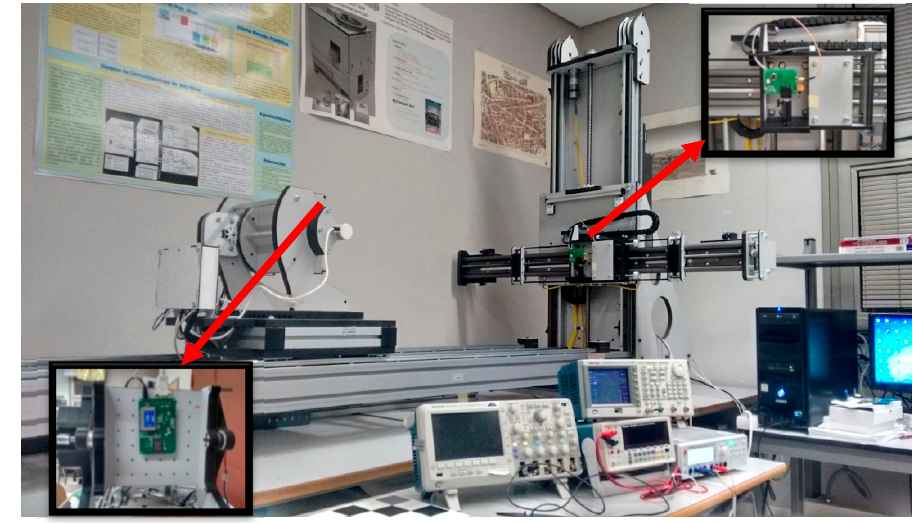
Figure 19. Infrastructure used for calibration.